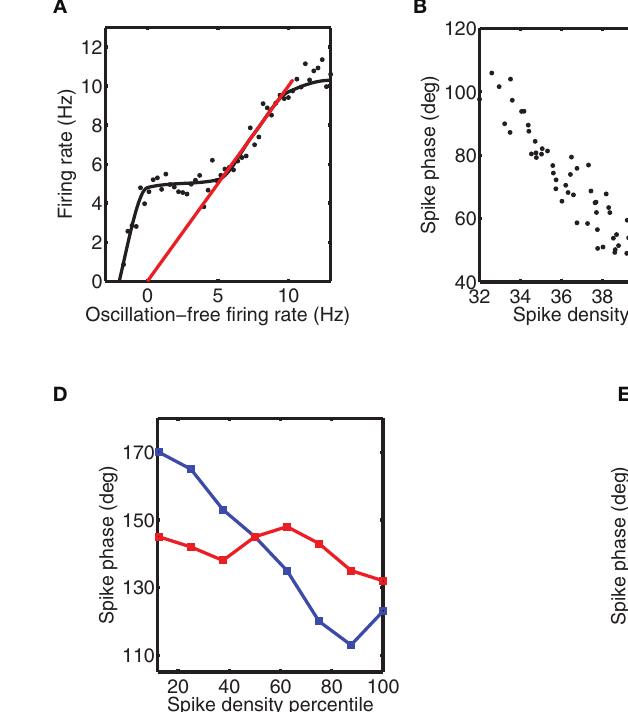
Figure 6 | Phase-shifting is observed in vitro and in vivo . (A) The firing rate in response to a tonic depolarizing current and a 5 Hz sinusoidal current versus the firing rate without the sinusoidal current. The firing rate was systematically varied by increasing the strength of the tonic current. The step is visible as the location where the firing rate on the y axis is constant, whereas that on the x axis changes. The dots are typical data points, whereas the solid line is the smooth curve that follows these points. The red line represents y = x . For the data points on this line, the addition of oscillatory current does not alter the firing rate. This graph is a schematic representation of the data shown in Figure 1C of McLelland and Paulsen (2009). (B) Phase-shifting of neurons in the primary visual cortex of the macaque. For these data the phase is taken relative to the LFP and is plotted against the spike density calculated by convolving the spike train with a Gaussian of a standard deviation of 50 ms. The graph is a schematic representation of Figure 4C of Vinck et al. (2010). (C) The spike phase relative to the sinusoidal current versus the oscillation-free firing rate for the data shown in (A) . This graph is a schematic